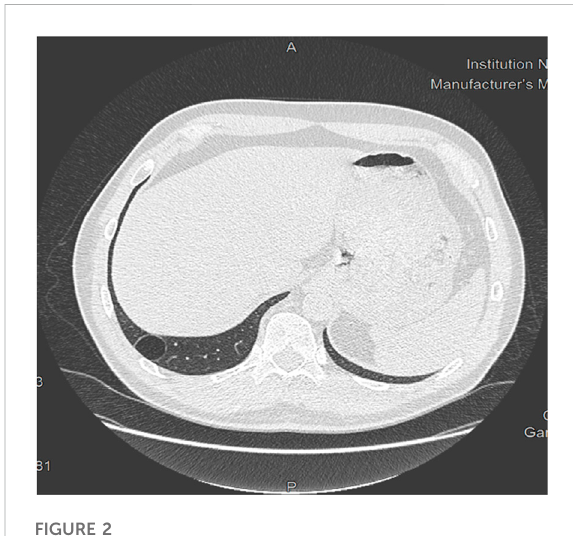
FIGURE 2 Chest CT scan showing a right basal subpleural cyst.